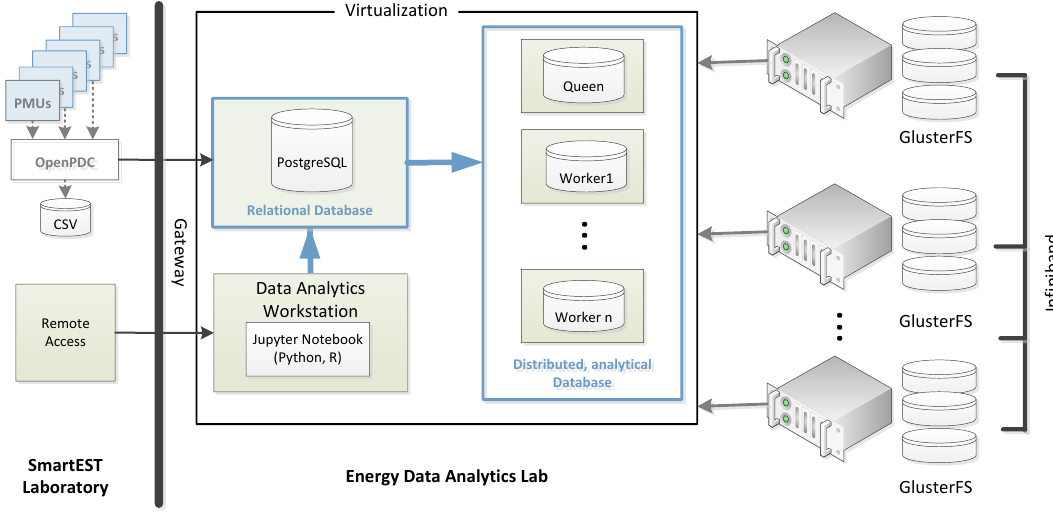
Figure 5. Data processing in the AIT Energy Data Analytics Cluster, with a conventional relational and the option for distributed, analytical database for real-time processing